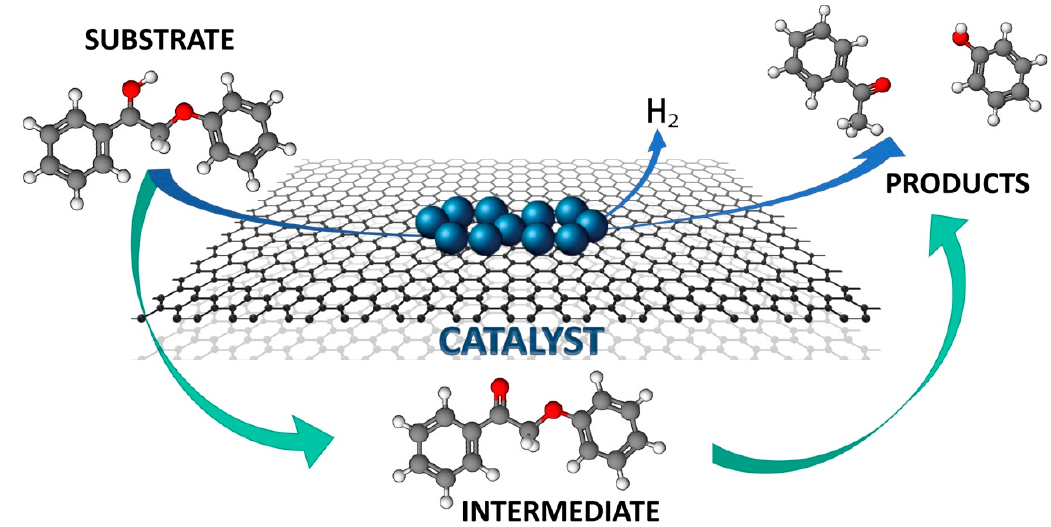
Figure 13. Schematization of a general reaction taking place on the surface of a generic 2D material.